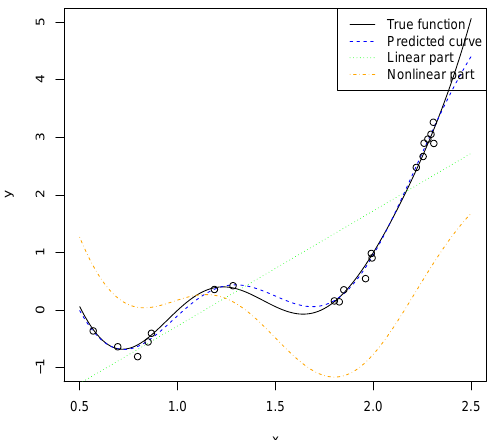
Figure 2. One simulation result of Example 1 in Section 5.2. Each dot represents an observation on randomly sampled